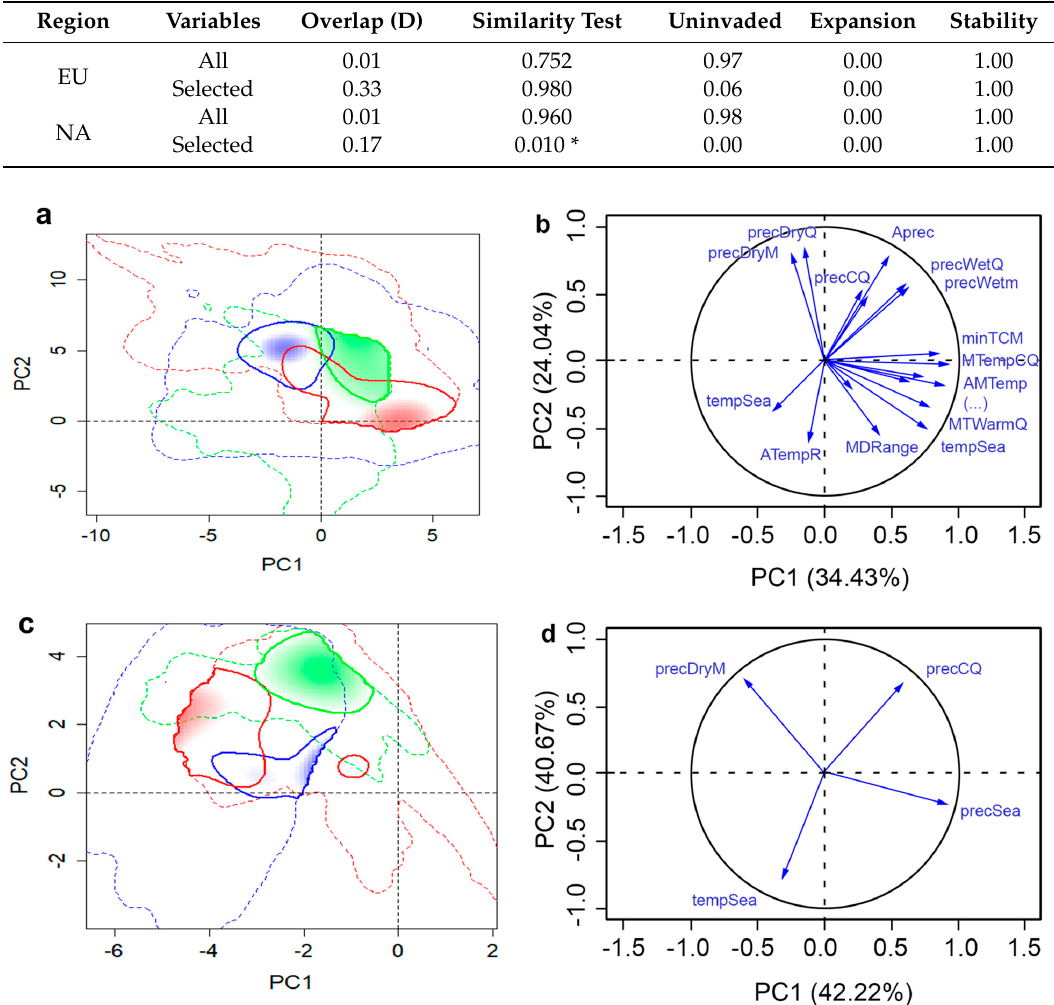
Figure 4. Native and invasive climatic niches of sudden oak death in Indochina (Vietnam), Europe, and North America along with variable factor maps. Multivariate climatic space was calculated using the PCA-env method. Results using all variables are shown in parts ( a ) and ( b ), whereas parts ( c ) and ( d ) shows the results obtained with selected variables. The solid and dashed lines delineate the niche occupied by the 50% densest population and all available climatic niche, respectively. Shadings correspond to the density of occurrences in each region: Europe (red, non-native), North America (blue, non-native), and Indochina (green, native), respectively. The variance explained by the PC1 and PC2 is 58.47% for all variables and 82.89% for selected variables. Table 4. Summary of p values for the niche test of sudden oak death between the presumed native range Indochina (Vietnam) and invasive ranges Europe (EU) and North America (NA) using all and selected climatic variables.